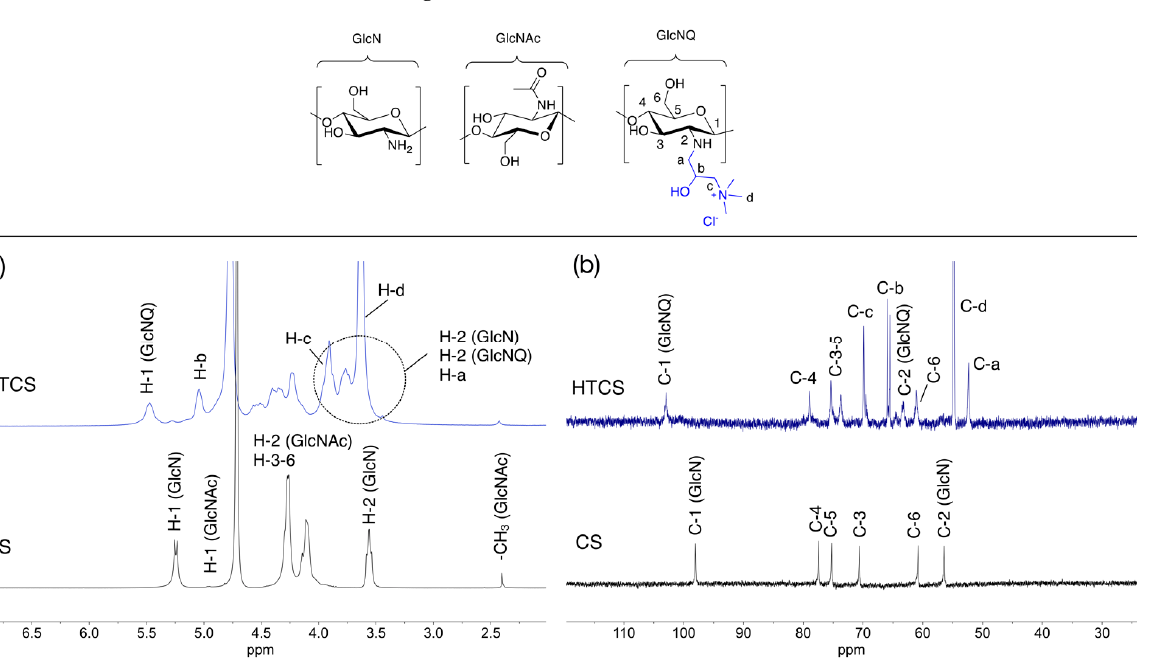
Figure 1. ( a ) 1 H NMR (400 MHz) and ( b ) 13 C NMR (100 MHz) spectra of CS (10 mg·mL − 1 ) and HTCS (20 mg·mL − 1 ) in D 2 O/DCl at 65 °C. The chemical structures of sugar units are inserted.